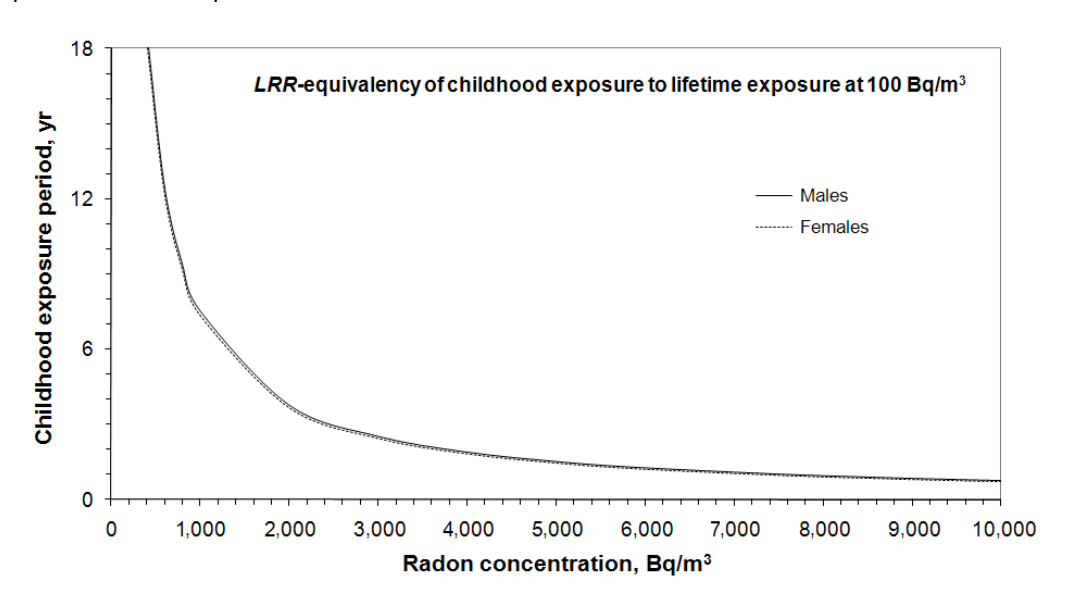
Figure 3. LRR -equivalency of short period high radon exposure in childhood to lifetime exposure to 100 Bq/m 3